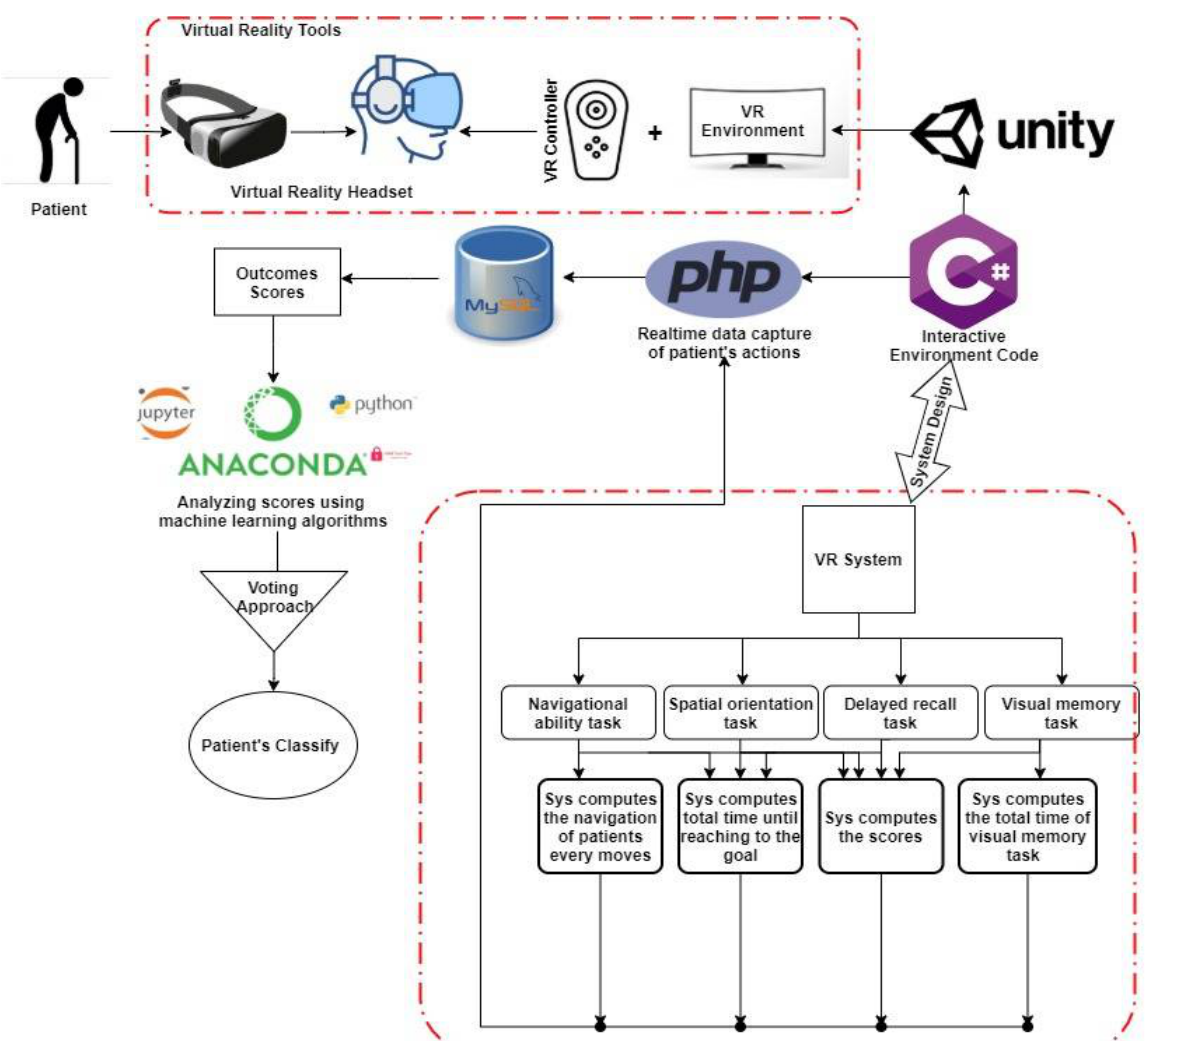
Figure 1. Architecture model for classifying dementia patients.